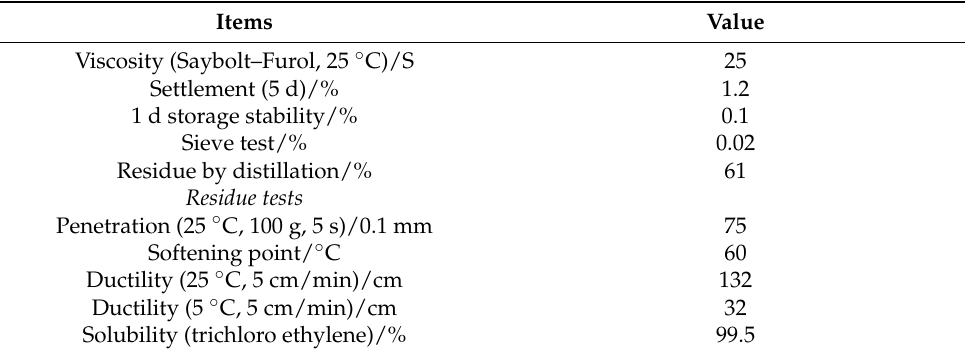
Table 1. Technical indexes of emulsified asphalt.